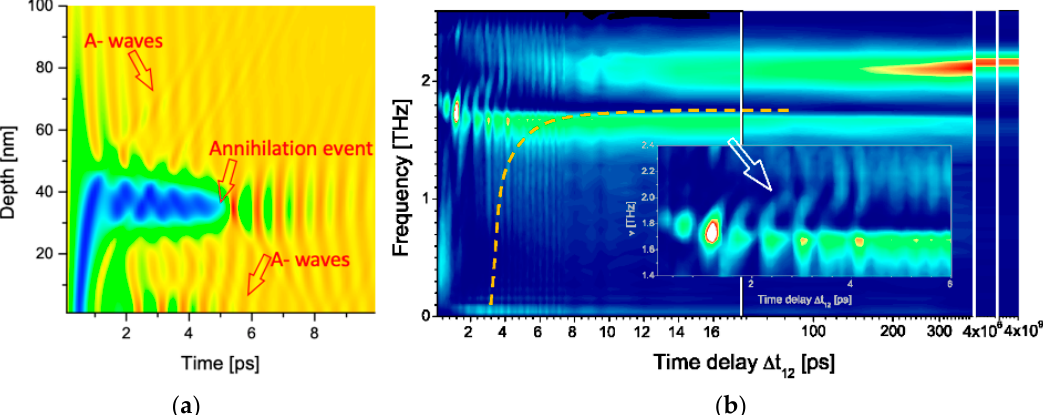
Figure 2. Coherent generation and annihilation of domains in photoexcitation experiments. ( a ) The calculated order parameter (in color depicts the AM power spectrum) shows domains parallel to the surface as a result of inhomogeneous pumping. The domain wall annihilation is visible at t = 4.5 ps, resulting in the generation of A-waves. The A-wave that travels towards the surface can be detected in the optical response of the A mode frequency. ( b ) The power spectra of the oscillatory response for the collective mode in DyTe 3 as a function of time after the phase transition at (cid:1872) = 0 . The soft-mode hardening is indicated schematically by the dashed line. The insert shows the anomalous behavior of the frequency as the A-waves emitted after domain wall annihilation reach the surface. (The arrow points to the anomalies).